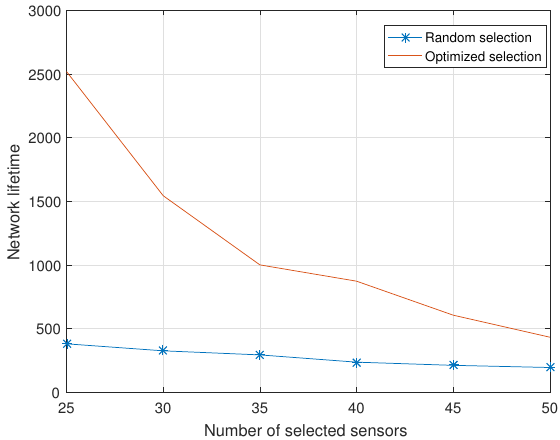
Figure 2. Network lifetime versus different number of selected sensor nodes.